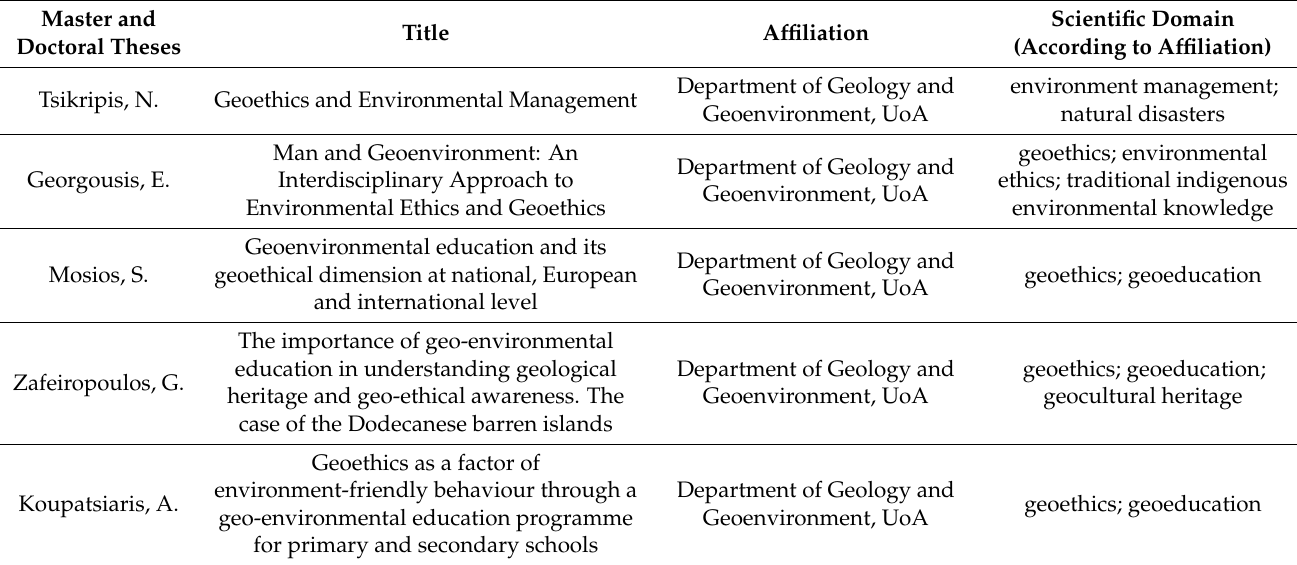
Table 1. Master’s and Doctoral Theses on Geoethics